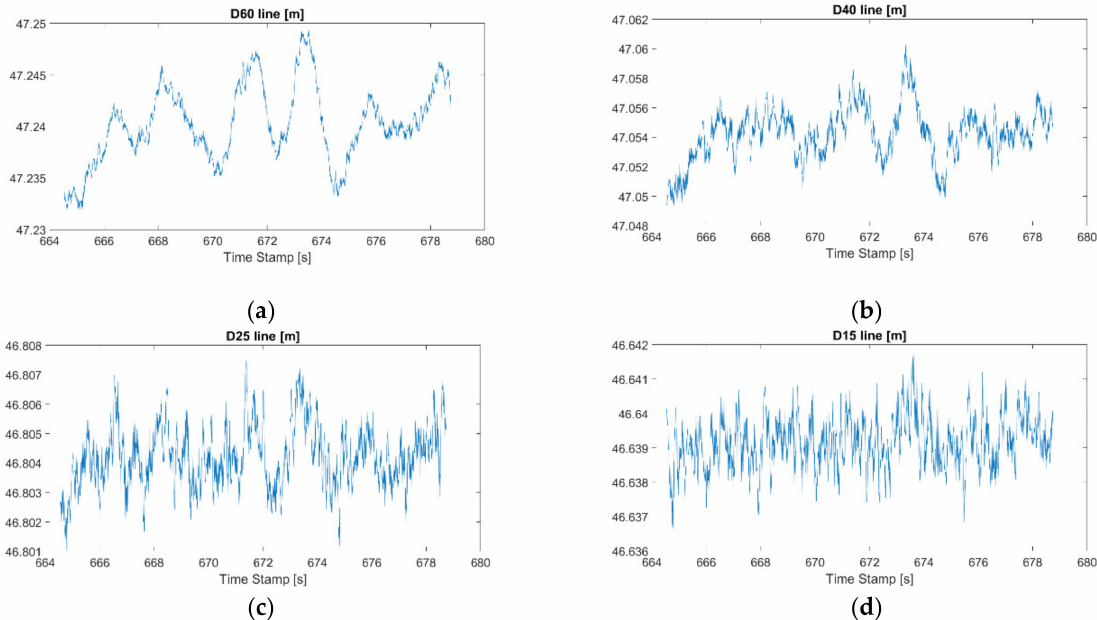
Figure 9. Ground distances from TLS of points at a height of 60 m (d 60 line), 40 m (d 40 line), 25 m (d 25 line) and 15 m (d 15 line) on the tower base. Abscissae are the timestamps in sec. The wind turbine is fully